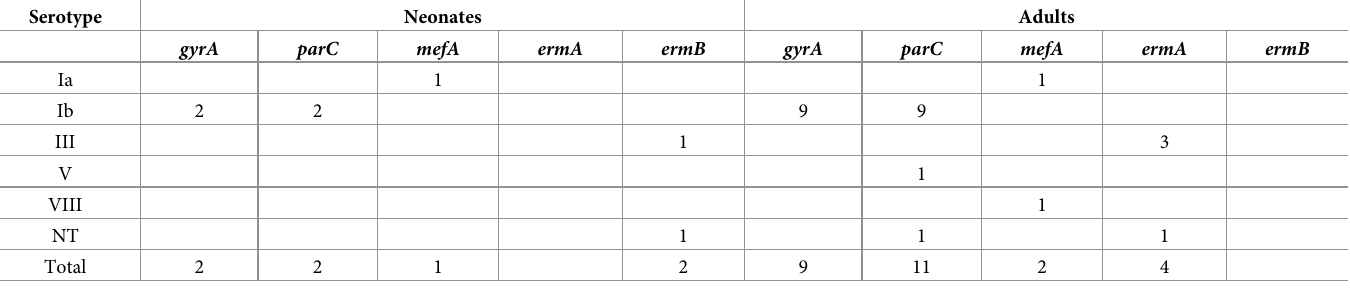
Table 6. Number of GBS isolates related between molecular serotype, levofloxacin resistance, and macrolide-resistant genes.